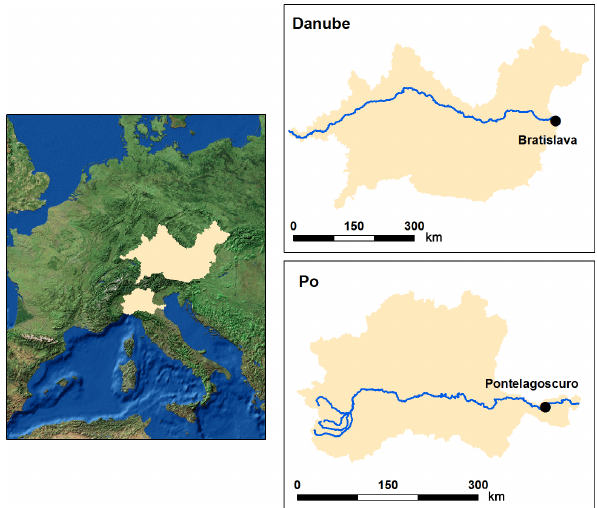
Figure 1. Study sites. Danube River basin at Bratislava and Po River basin at